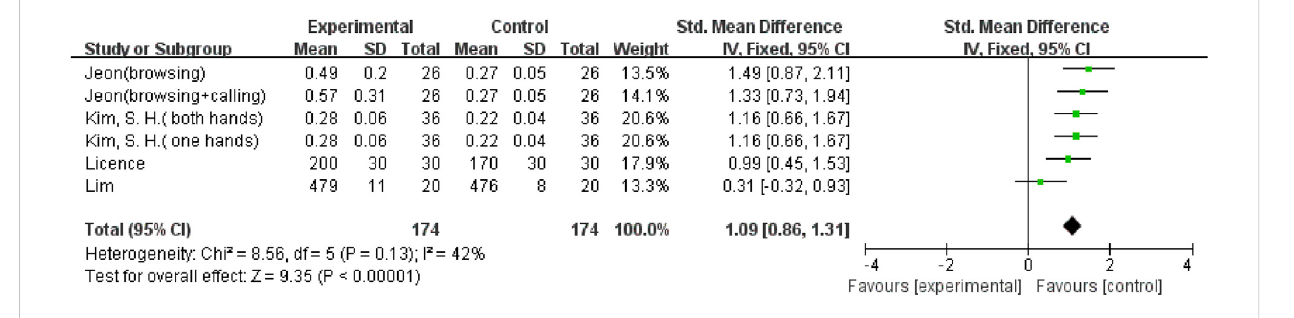
FIGURE 9 The effect of mobile phone use on double support